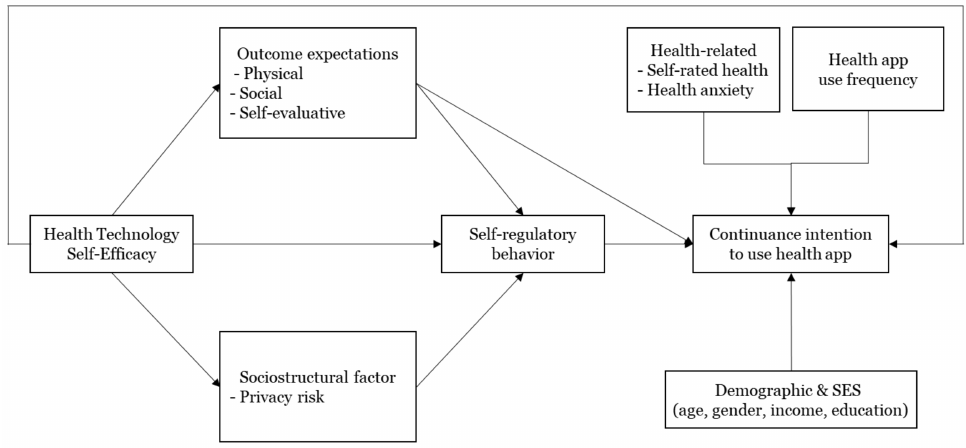
Figure 2. Research